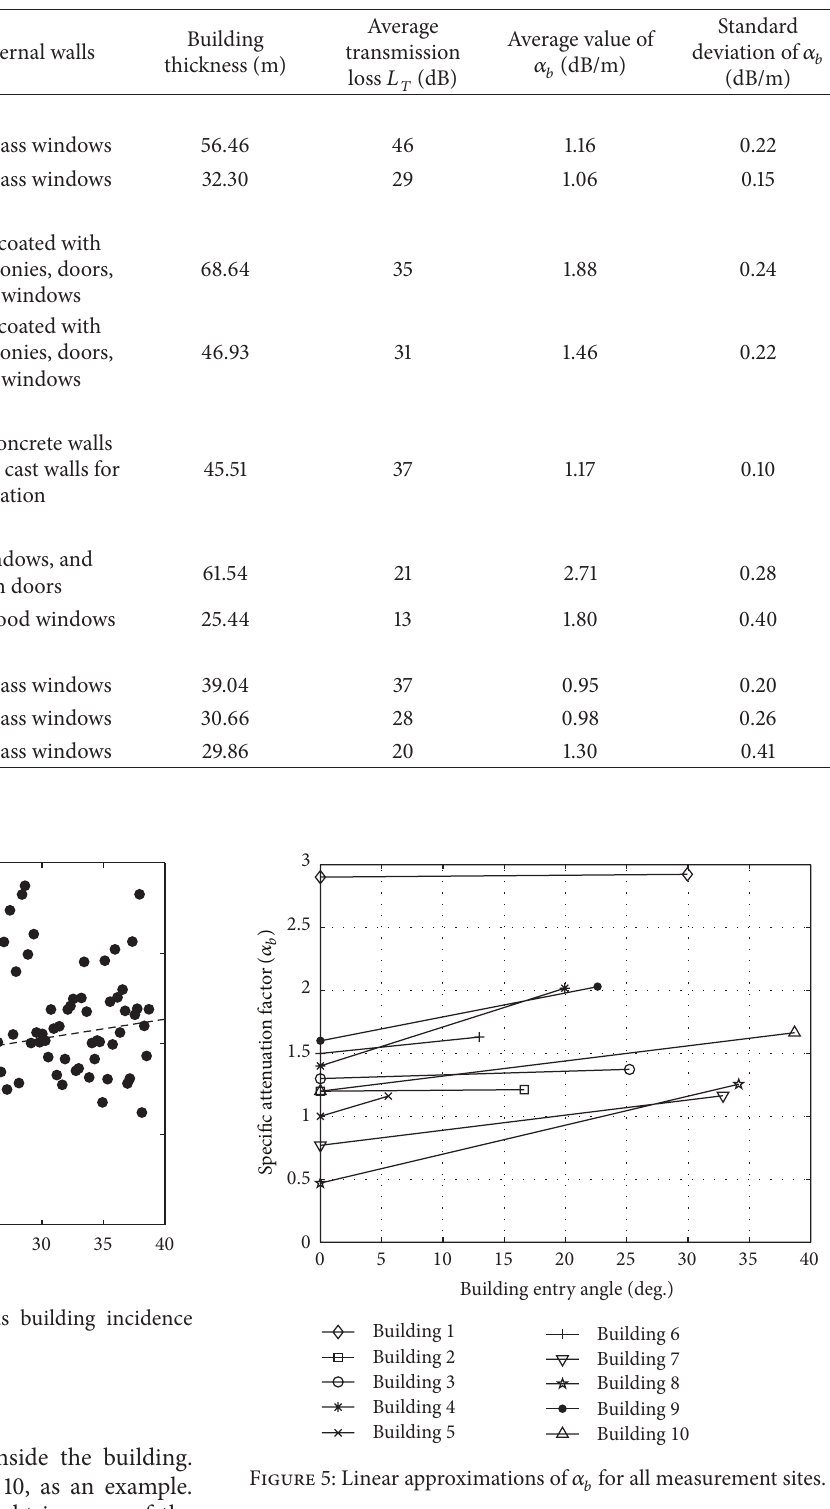
Table 2 shows the average values and standard deviation of 𝛼 𝑏 for each building. The average value of the transmission loss is also